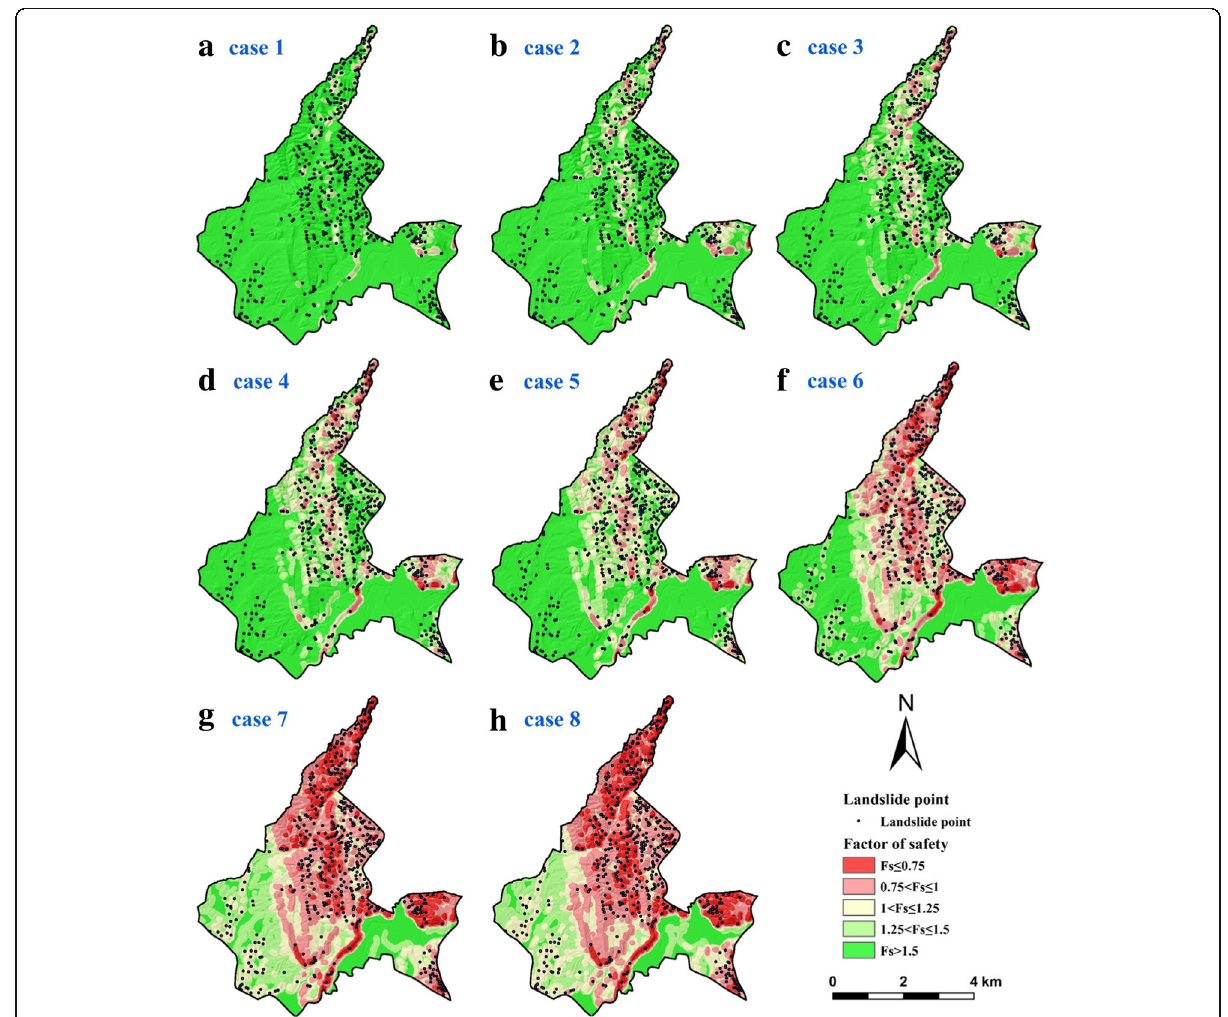
Fig. 10 Factor-of-safety maps calculated with different horizontal pseudo-acceleration